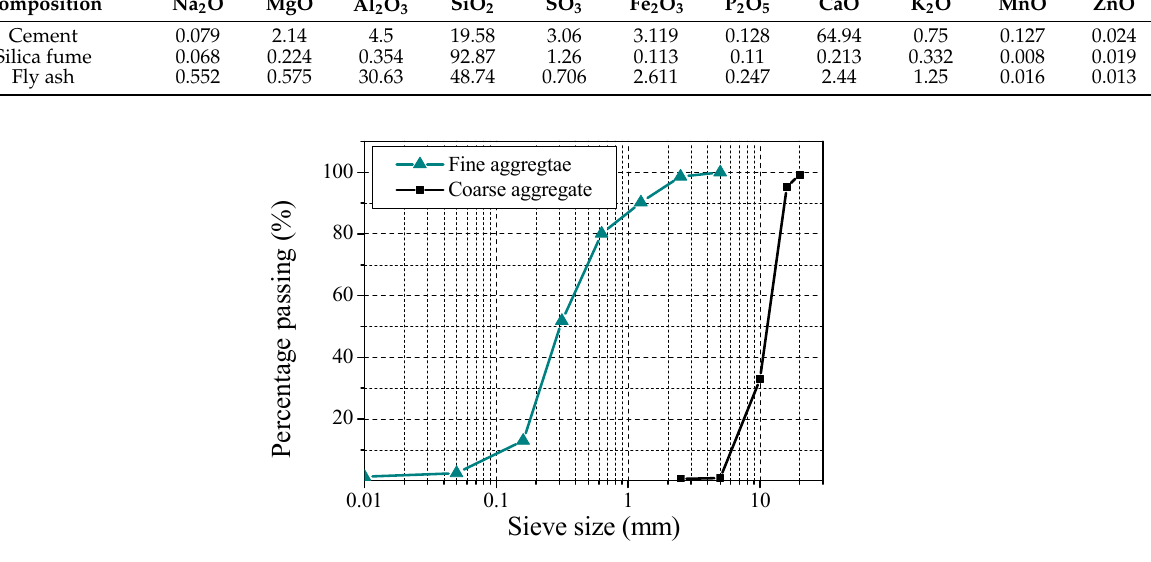
Figure 2. Grading curves of fine and coarse aggregates.